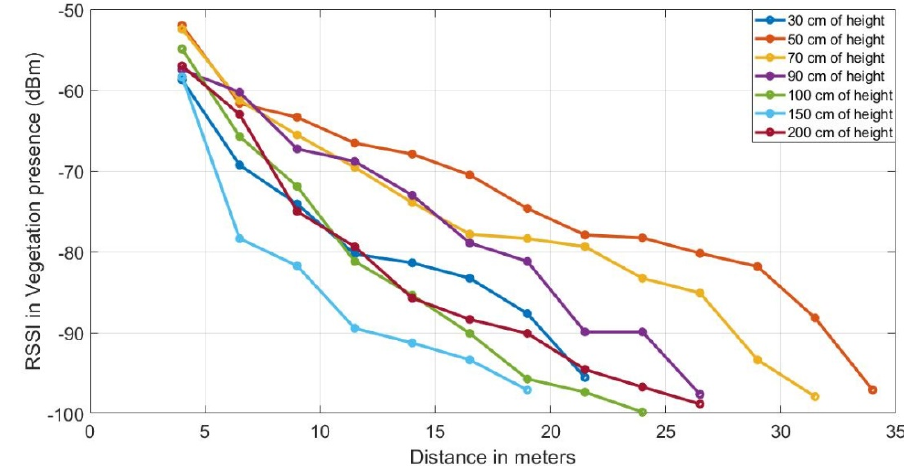
Figure 5. Received signal level average in dBm of the four locations, with line of sight obstructed by tomato plant walls between transmitter (Tx) and receiver (Rx) nodes at different heights from the ground (30 cm, 50 cm, 70 cm, 90 cm, 100 cm, 150 cm).